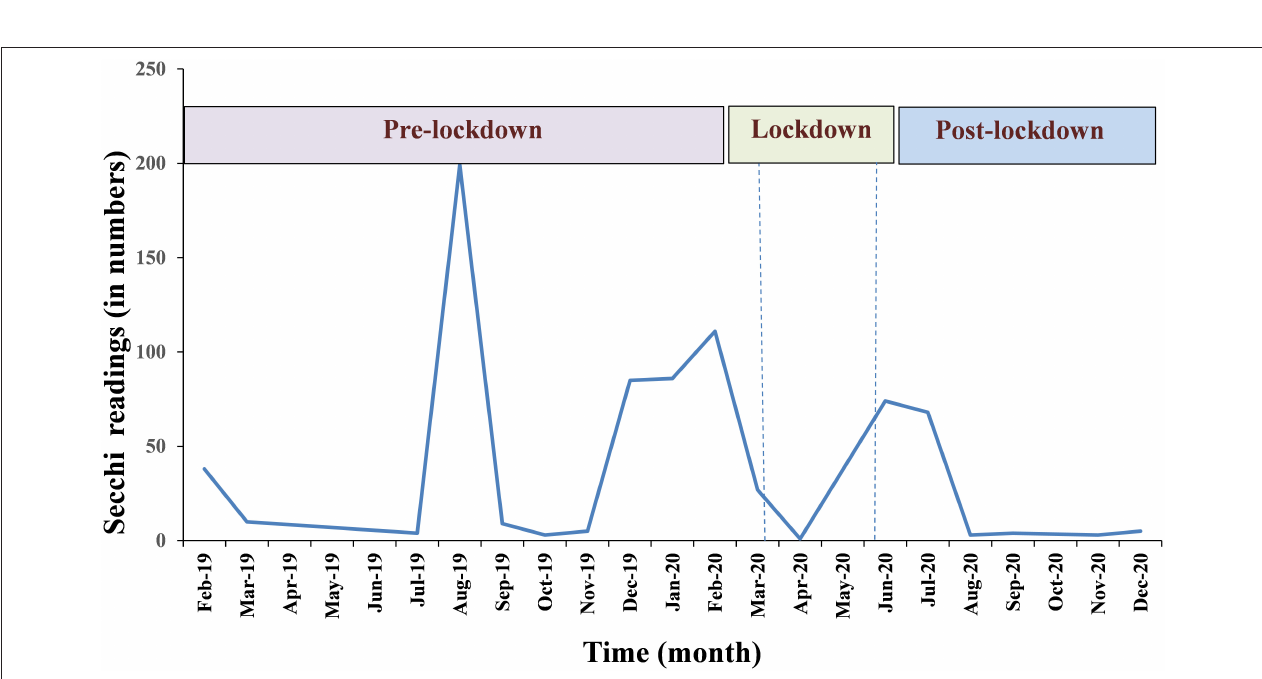
FIGURE 4 | Variability in the number of Secchi readings during different phases of COVID related restrictions—pre-lockdown, lockdown, and post-lockdown.